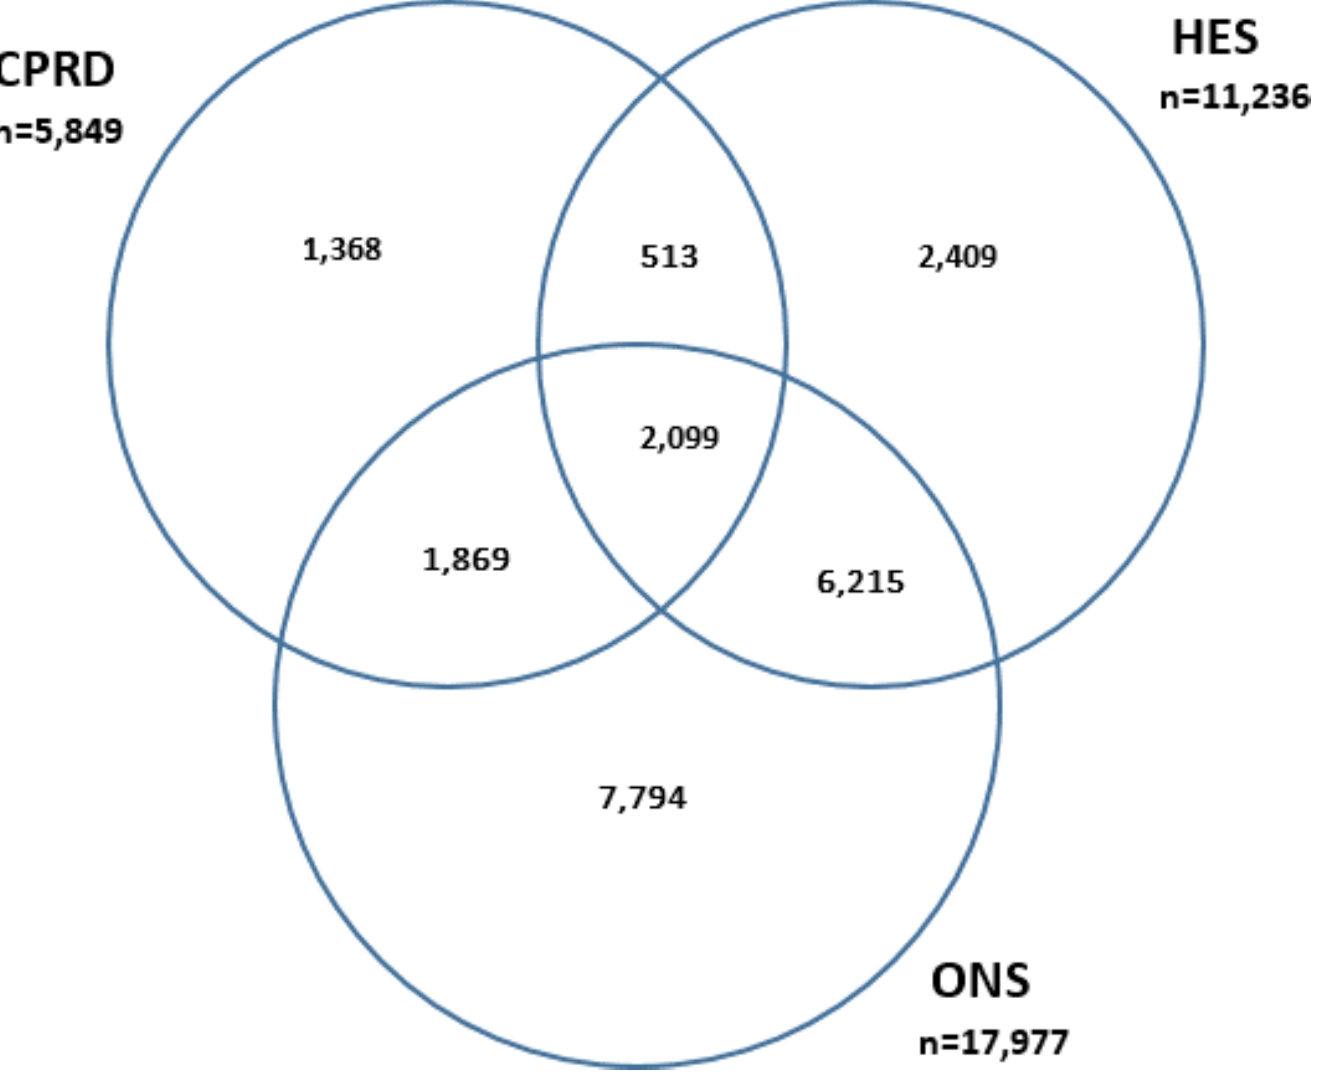
Figure 3 Number of fatal strokes recorded in primary care (CPRD: 30- day definition), in hospital care (HES: discharge status), and ONS (underlying cause of death). Total CPRD n = 54 929; total HES n = 51 013. CPRD = Clinical Practice Research Datalink. HES = Hospital Episode Statistics. ONS = Office for National